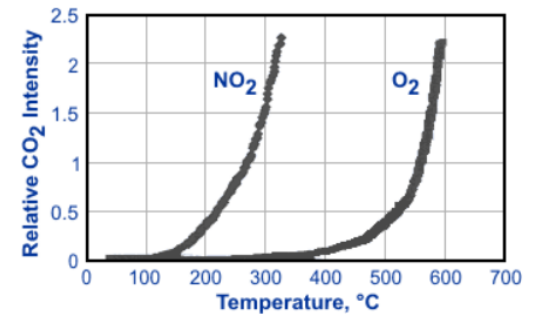
Fig. 3. Oxidation of PM by oxygen and nitrogen dioxide [13]